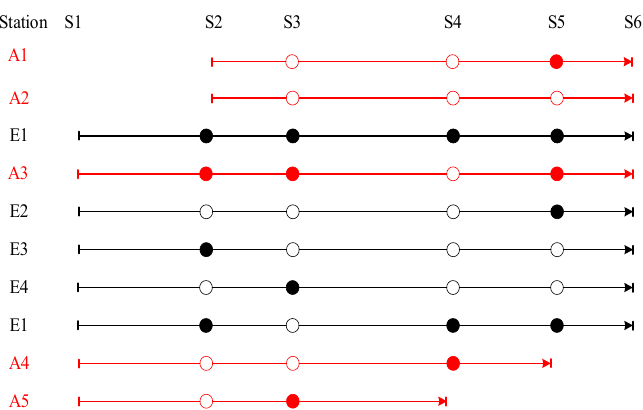
Figure 5. Stop plans for existing trains and additional train.